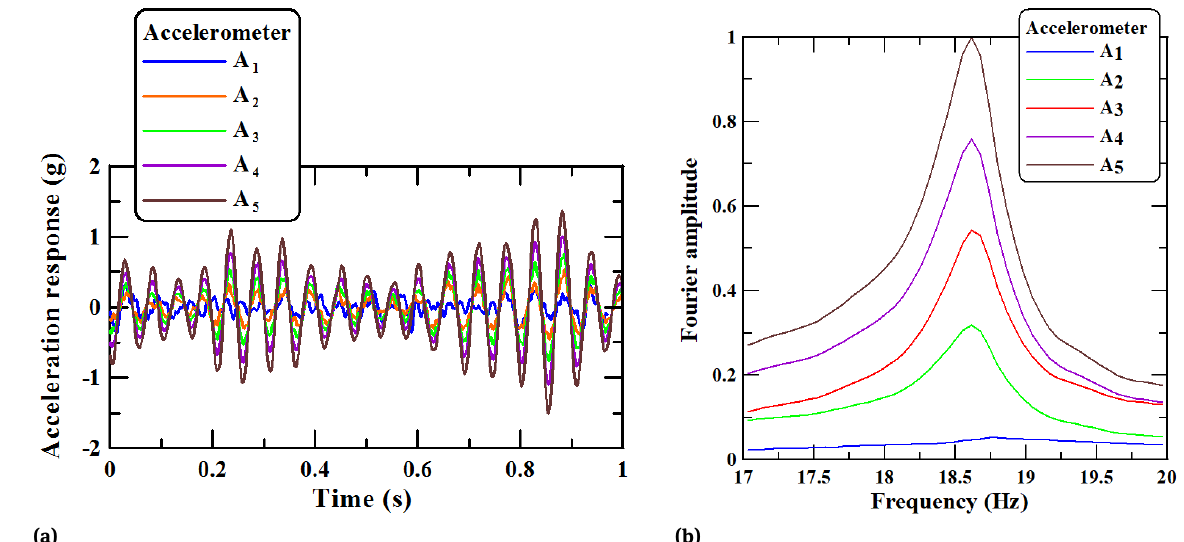
Figure 4: (a) Enlarged view of time history response and (b) normalized Fourier amplitude